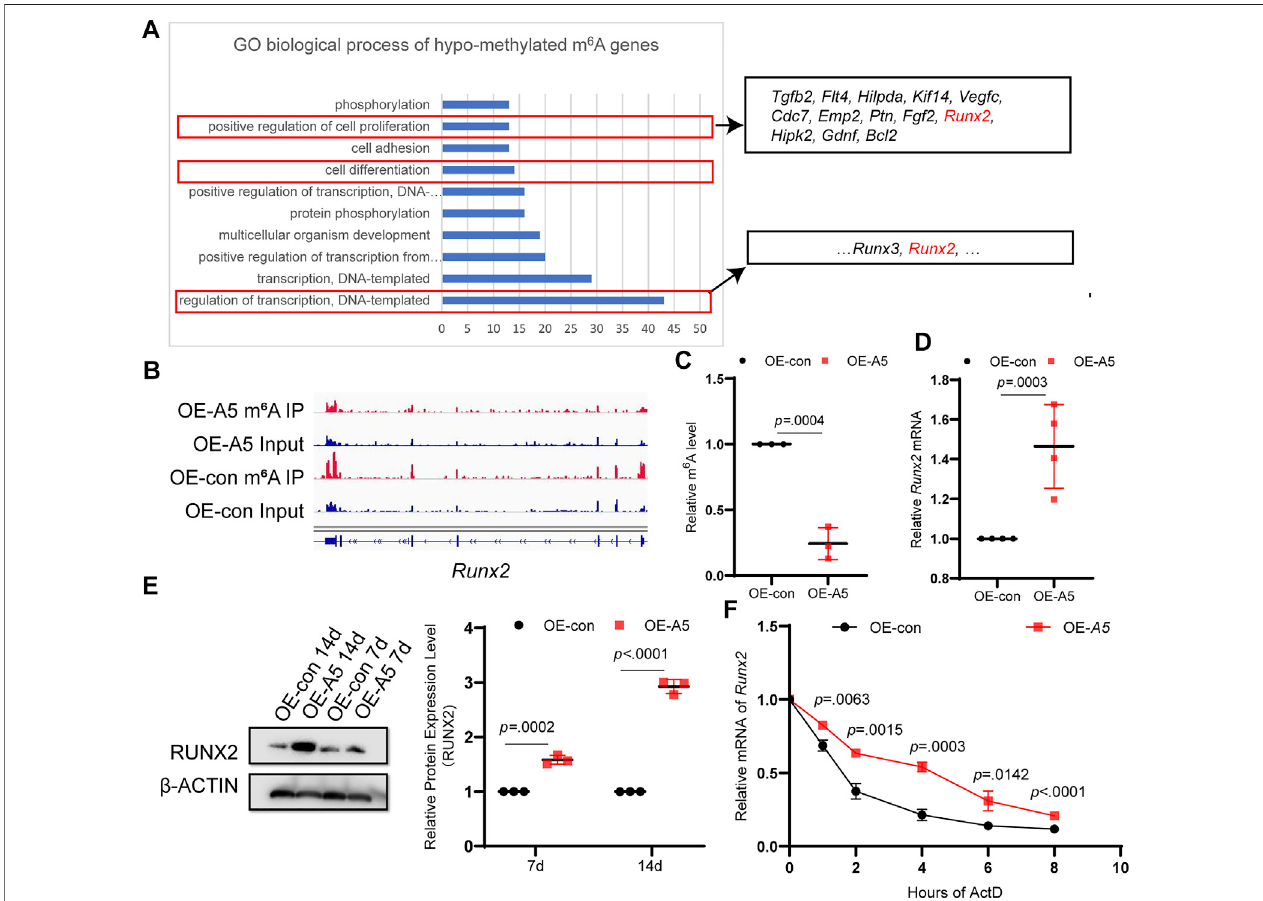
FIGURE 5 | ALKBH5 modulated the stability of Runx2 in an m 6 A-dependent manner. (A) GO enrichment analysis of differentially expressed genes in the hypomethylatedm 6 Agroup,whichincluded Runx2 . (B) Them 6 Apeaksof Runx2 wereanalyzedusingIntegrativeGenomicsViewersoftware. (C) m 6 A-IP-qPCRanalysis of Runx2 mRNA m 6 A modi fi cation in the Alkbh5 overexpression and control groups. (D) Runx2 mRNA expression level was measured using qPCR. (E) RUNX2 protein expression level was determined using western blotting. (F) The RNA stability of Runx2 was determining by detecting the transcript abundance in mDPC6T cells transfected with negative or overexpressing lentivirus targeting Alkbh5 after the addition of actinomycin (D) . Alkbh5, AlkB homolog H5; GO, Gene Ontology; Runx2, Runt-related transcription factor 2; m 6 A, N6-methyladenosine; qPCR, quantitative polymerase chain reaction.